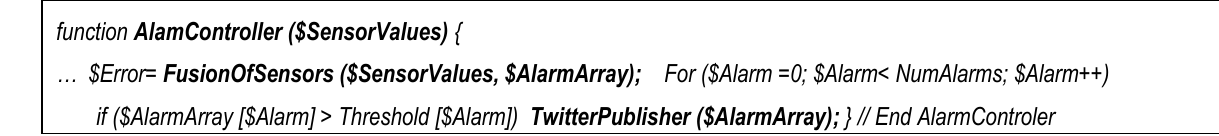
Figure 19. The PHP code of the Alarm controller (including sensors fusion